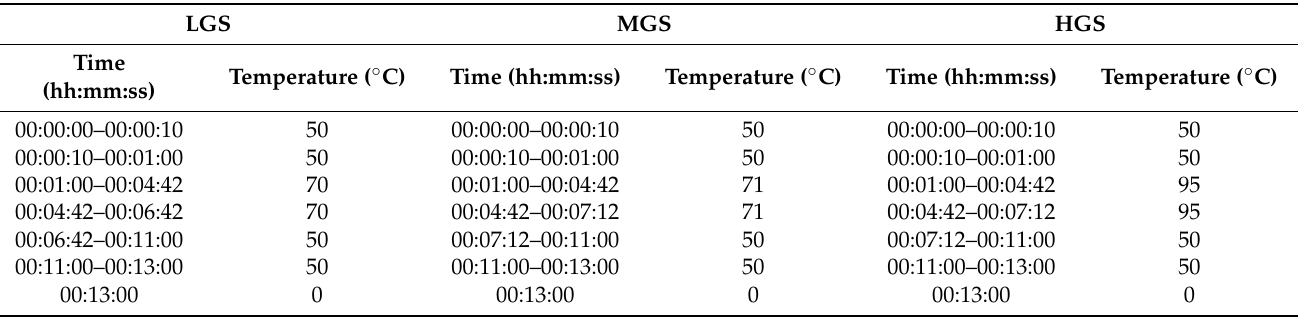
Table 1. RVA gelatinization